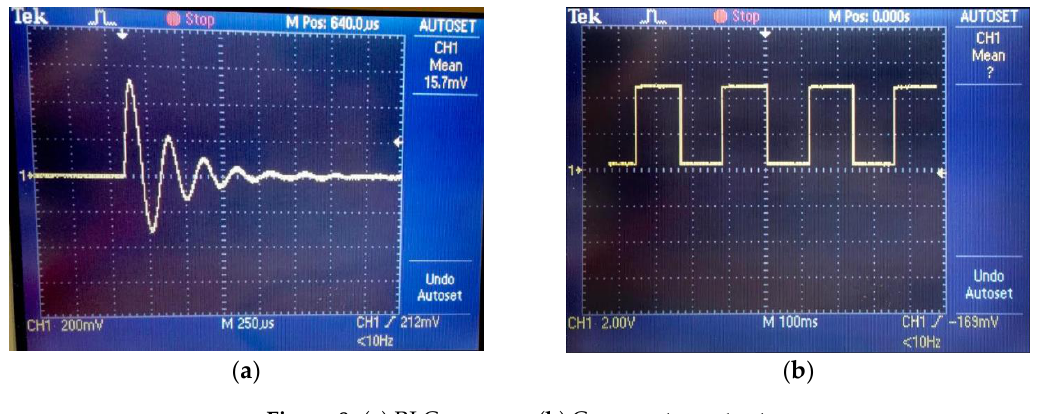
Figure 8. ( a ) RLC response ( b ) Comparator output.